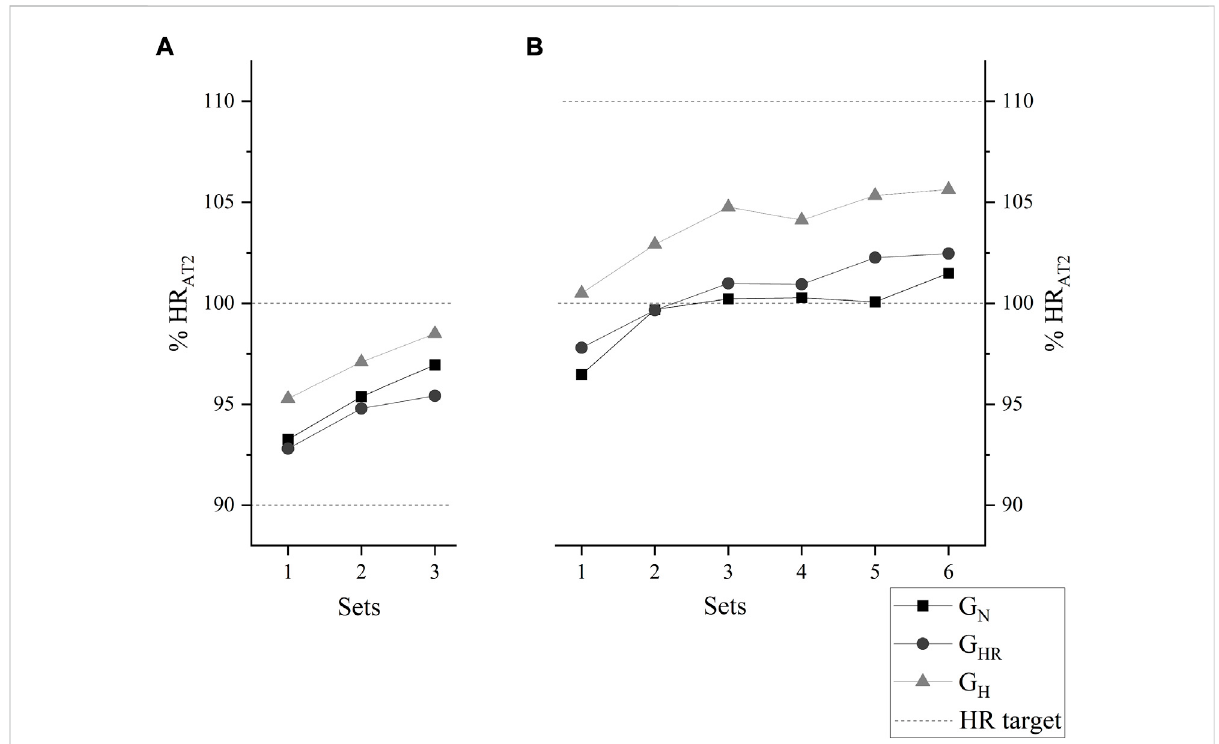
FIGURE 5 Averageheartraterelativetotheanaerobicthreshold2(HR AT2 )kineticsattheendofeachset,atweek1,correspondingto90% – 100% (A) ,andat week 8, corresponding to 100% – 110% (B) . G N = group in normoxia; G HR = group in hypoxia recovery; G H = group in